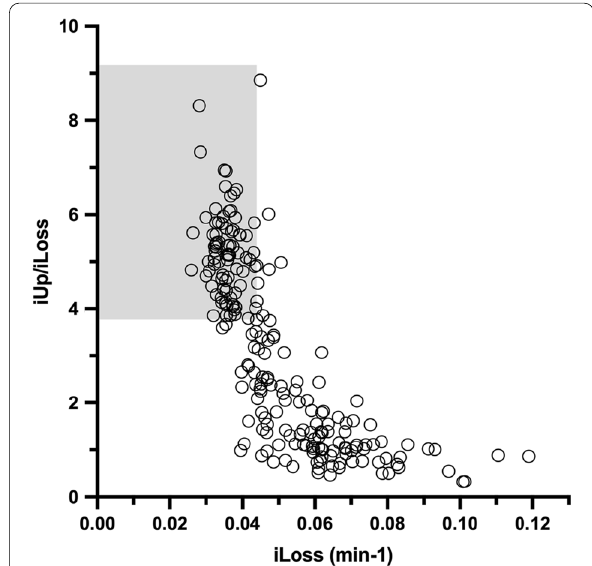
Fig. 3 The scatter plot of iLoss (min − 1 ) versus iUp/iLoss obtained from 208 patients. The shaded rectangle represents a territory based on the cut‑off values for iLoss and iUp/iLoss shown in Table 6. Note that high values of iLoss were counterbalanced by iUp to some extent